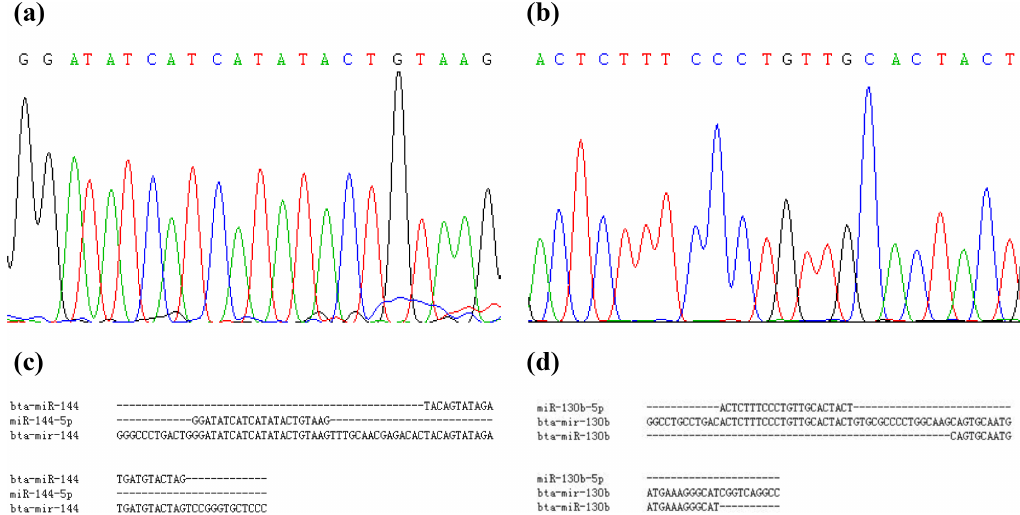
Figure 1. (a) Sequencing chromatograms for miR-144-5p . (b) Sequencing chromatograms for miR-130b-5p . (c) The bta-mir-144 sequence comparison with bta-miR-144 and miR-144-5p . (d) The bta-mir-130b sequence comparison with bta-miR-130b and miR-130b-5p .